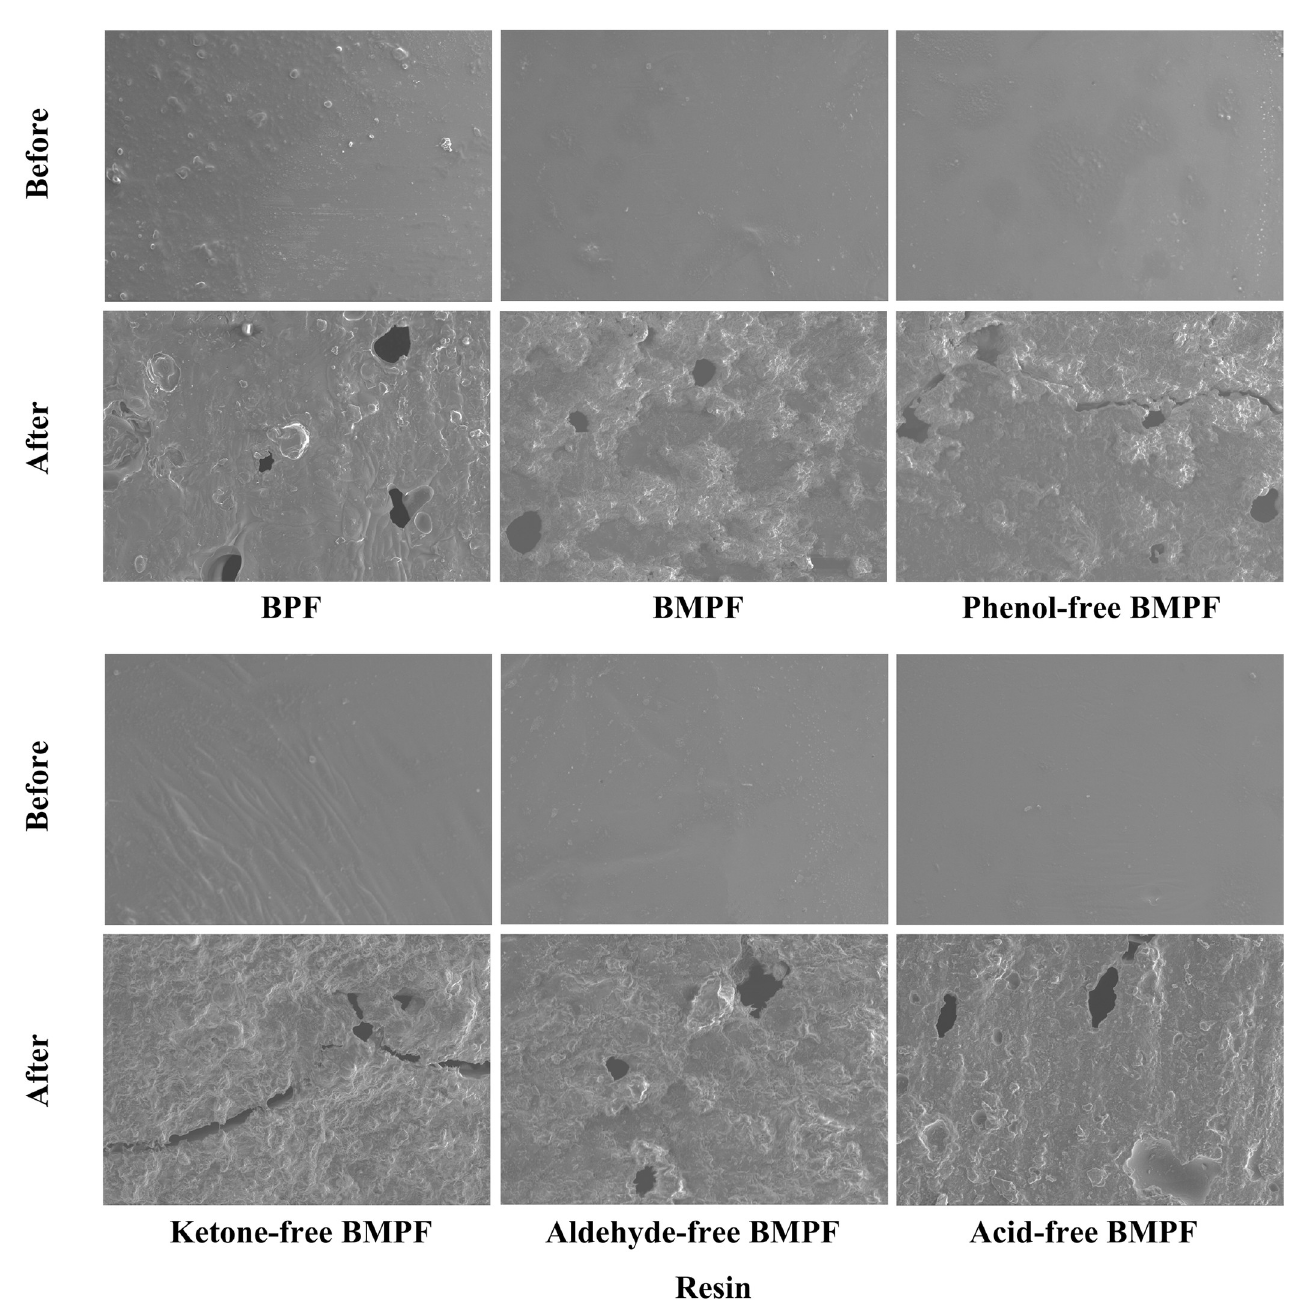
Fig 4. SEM images of BMPF films before and after aging for 960 h ( × 500).